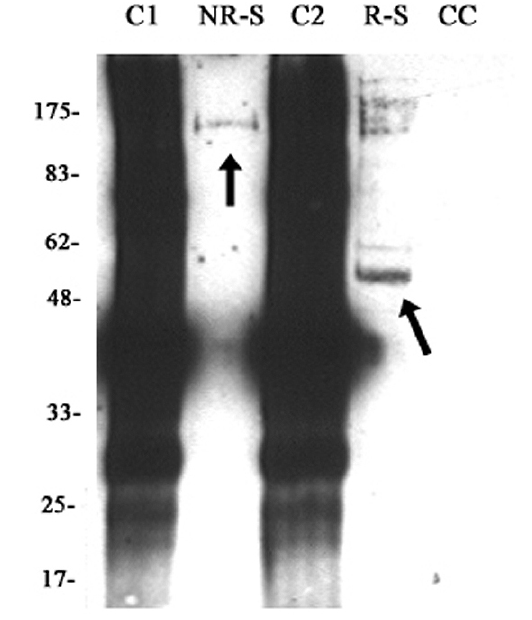
FIGURE 8. Western blot of biotinylated decorin core protein cross-linked to the putative endocytosis receptor protein. Human skin fibroblasts in monolayer culture were allowed to internalize btn-DCN-SASD for 10 min, followed by covalent cross-linking of biotinylated decorin to nearby bound proteins upon photoactivation. Cell surface associated proteins were digested by trypsinization at 37°C, cells were extracted, and proteoglycans were purified by DEAE-anion exchange chromatography. Proteoglycans were digested with chondroitin ABC lyase and separated by 12.5% SDS-PAGE under reducing (R-S) and nonreducing (NR-S) conditions, respectively, followed by electrotransfer to a nitrocellulose membrane. As a control, 75 ng of biotinylated decorin (C1, C2), as well as an extract of the same cell line to which no decorin was added, (CC) were used. The application of 75 ng of decorin led to an overloaded signal compared to the DEAE-purified cell extracts. Biotinylated decorin core protein was detected on the nitrocellulose membrane using peroxidase-conjugated extravidin followed by ECL detection. A molecular weight shift of about 110 kDa (arrows) is observed upon release of the decorin core protein from the cross-linked receptor protein by reduction with